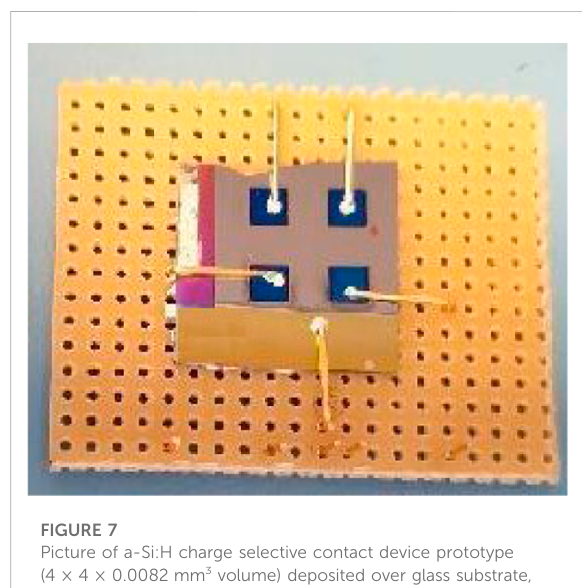
FIGURE 7 Picture of a-Si:H charge selective contact device